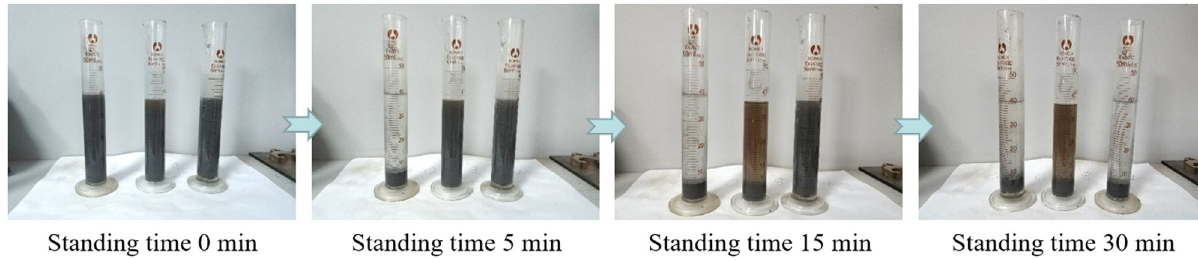
Figure 5: Suspension standing phenomenon ( from left to right: GO/KT composites, GO/T composites, and KT ) .